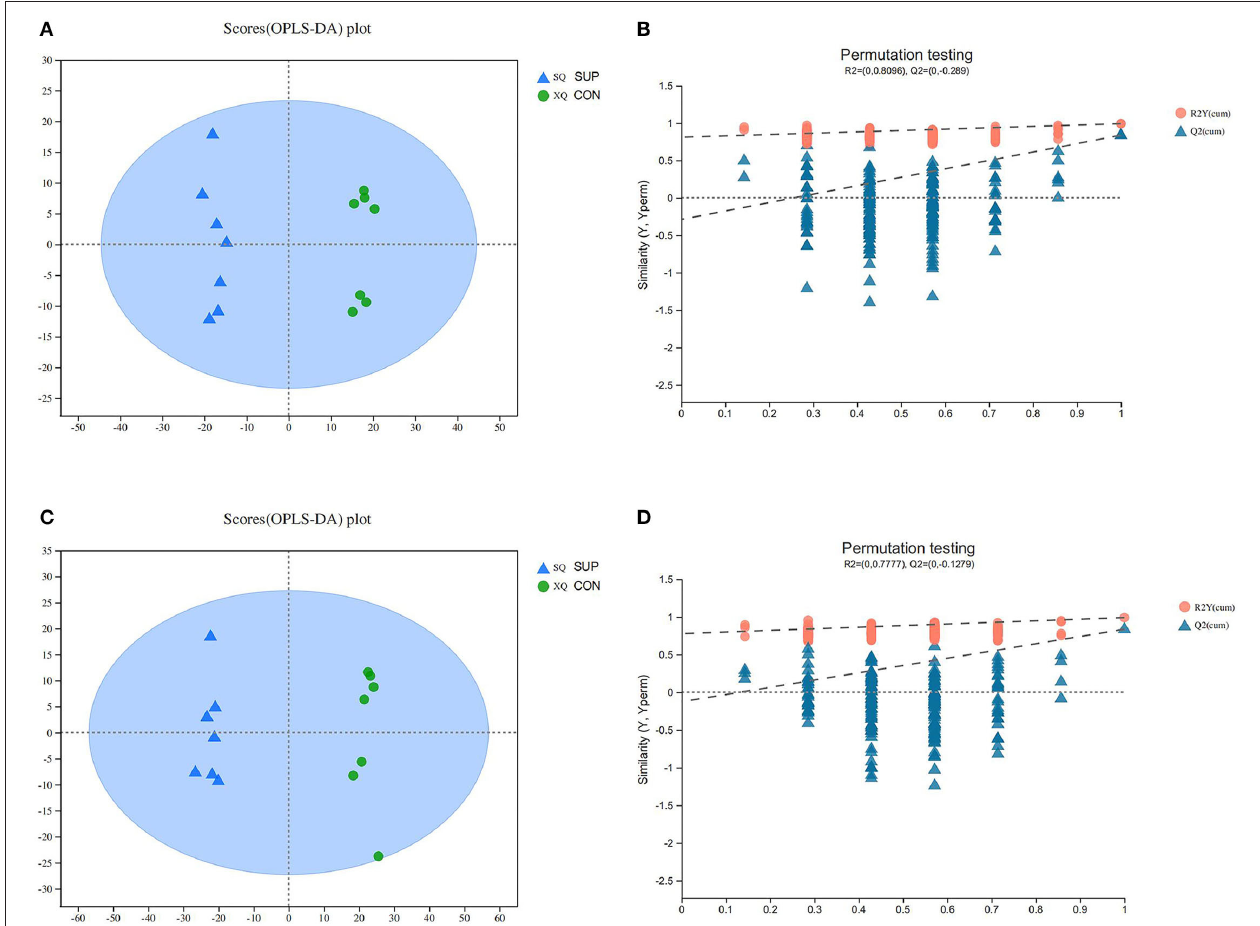
FIGURE 1 | Corresponding validation plots of orthogonal projections to latent structures-discriminate analysis (OPLS-DA) and permutation test of the OPLS-DA model (B,D) were derived from the UHPLC-QTOF/MS metabolomics profiles of serum. (A,B) and (C,D) were respectively, derived from POS and NEG for the serum samples. Blue and green respectively, represent SUP and CON administration to heifers. SUP, supplementation heifers; CON, grazing heifers. n =